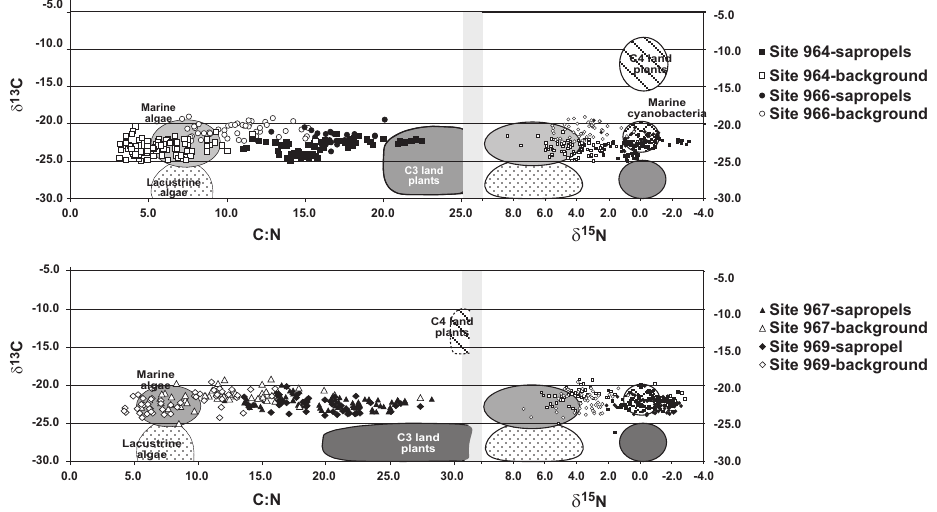
Fig. 14. Origin of the organic matter contained in the sampled sapropels as a function of d 15 N, d 13 C and C:N ratios.